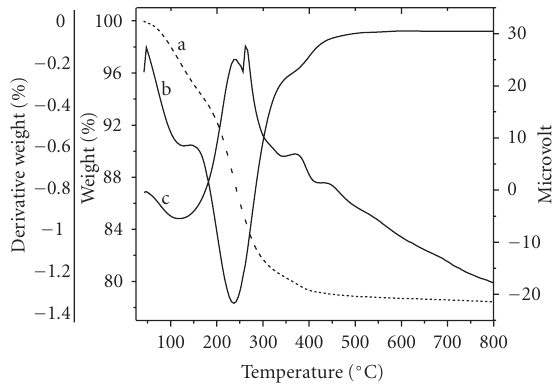
Figure 5: Thermal analysis data on hydrothermally prepared un- calcined Au/TiO 2 gel (sample H1): (a) TG, (b) DTG, and (c)